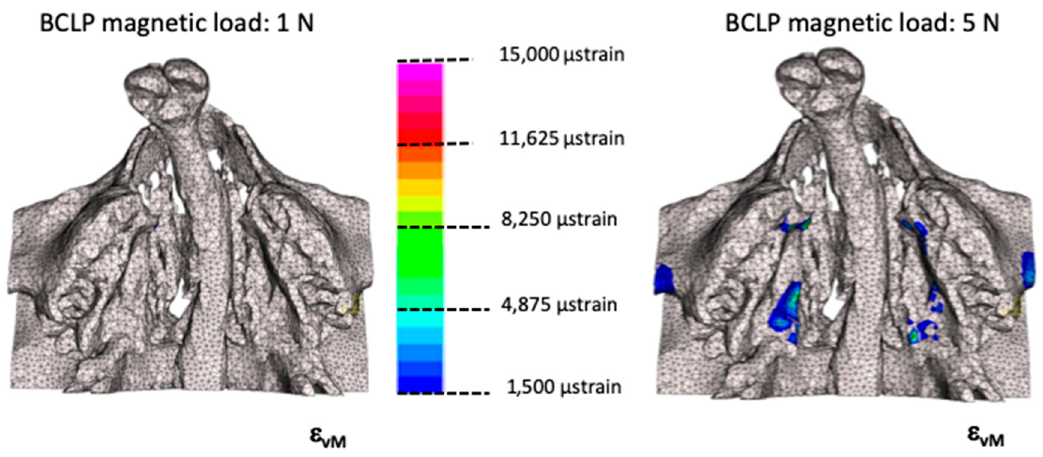
Figure 4. Areas showing the overall strain levels in BCLP model during loading of 1 N (left) and 5 N (right) from the palatal view.